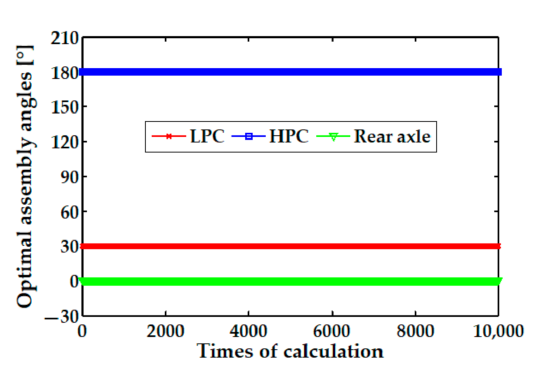
Figure 13. The optimal solution of the single-objective optimization for the coaxiality in the 10,000 times simulations.